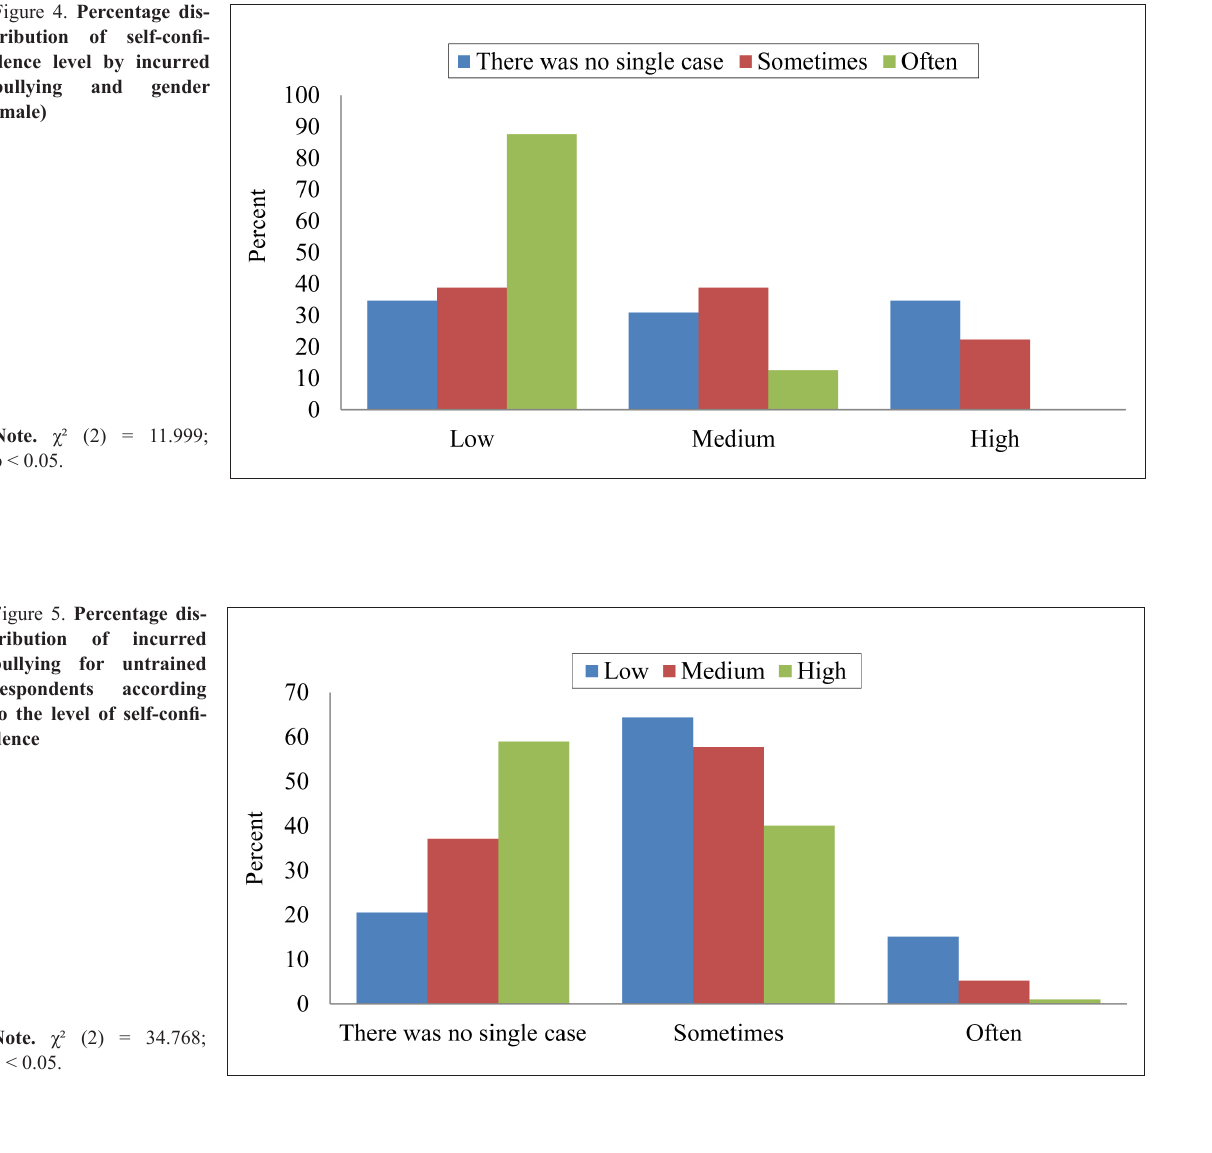
Figure 6. Percentage distribution of incurred bullying for athletes respondents according to the level of